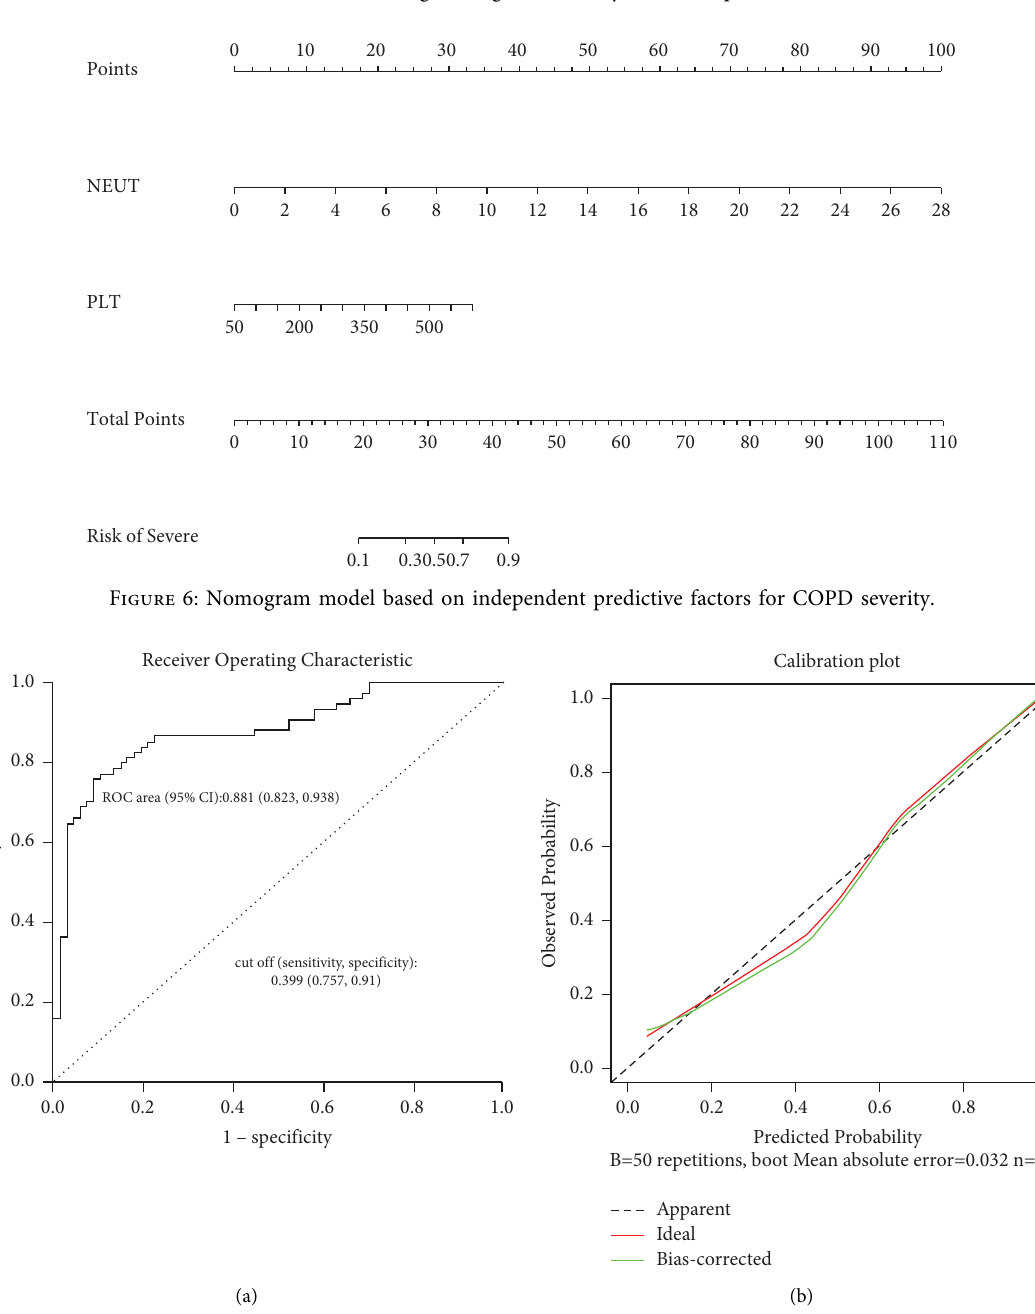
Figure 5: Multivariate logistic regression analysis with stepwise method.